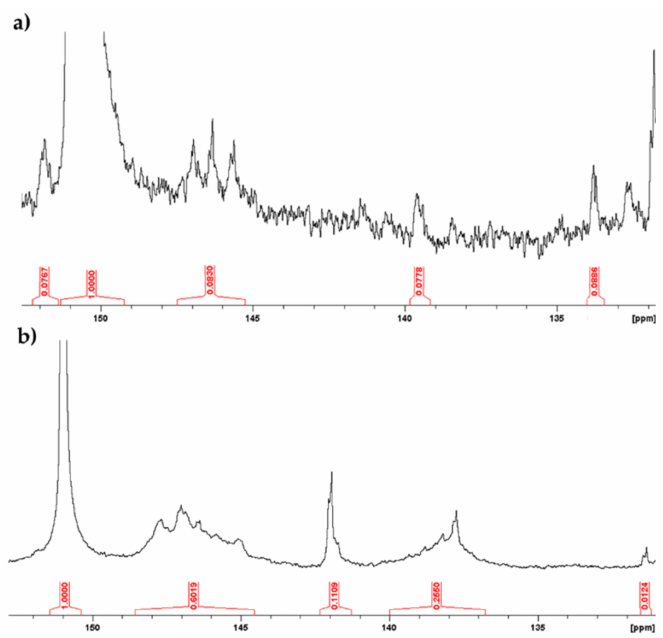
Figure 4. 31 P NMR of pyomelanin mimics. Spectra were recorded after derivatization of the samples as reported in reference [28]. ( a ) 31 P NMR of HGAm. ( b ) 31 P NMR of